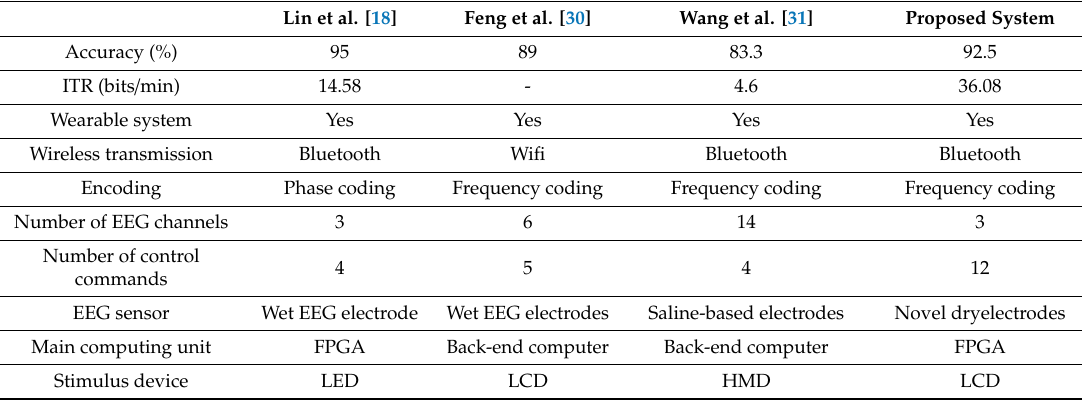
Table 1. Comparison between the proposed system and other SSVEP-based systems. Lin et al. [18] Feng et al. [30] Wang et al.